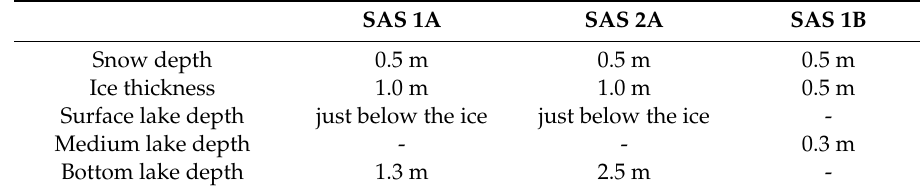
Table 1. Surface, medium, and bottom sampling depths for SAS 1A, SAS 1B, and SAS 2A, as well as the corresponding snow depth and ice thickness of each